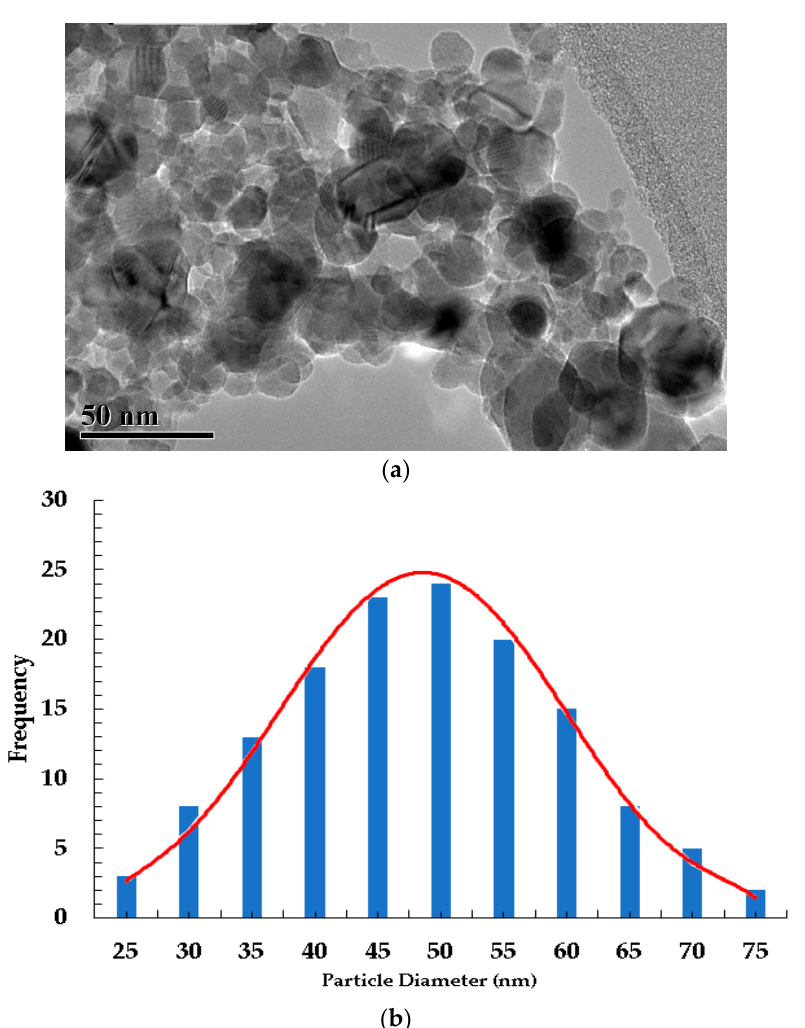
Figure 12. Individual particle sizes as extracted from TEM images for the first batch: ( a ) TEM image of the particles and ( b ) the log-normal distribution with a 48.53 nm average particle diameter.